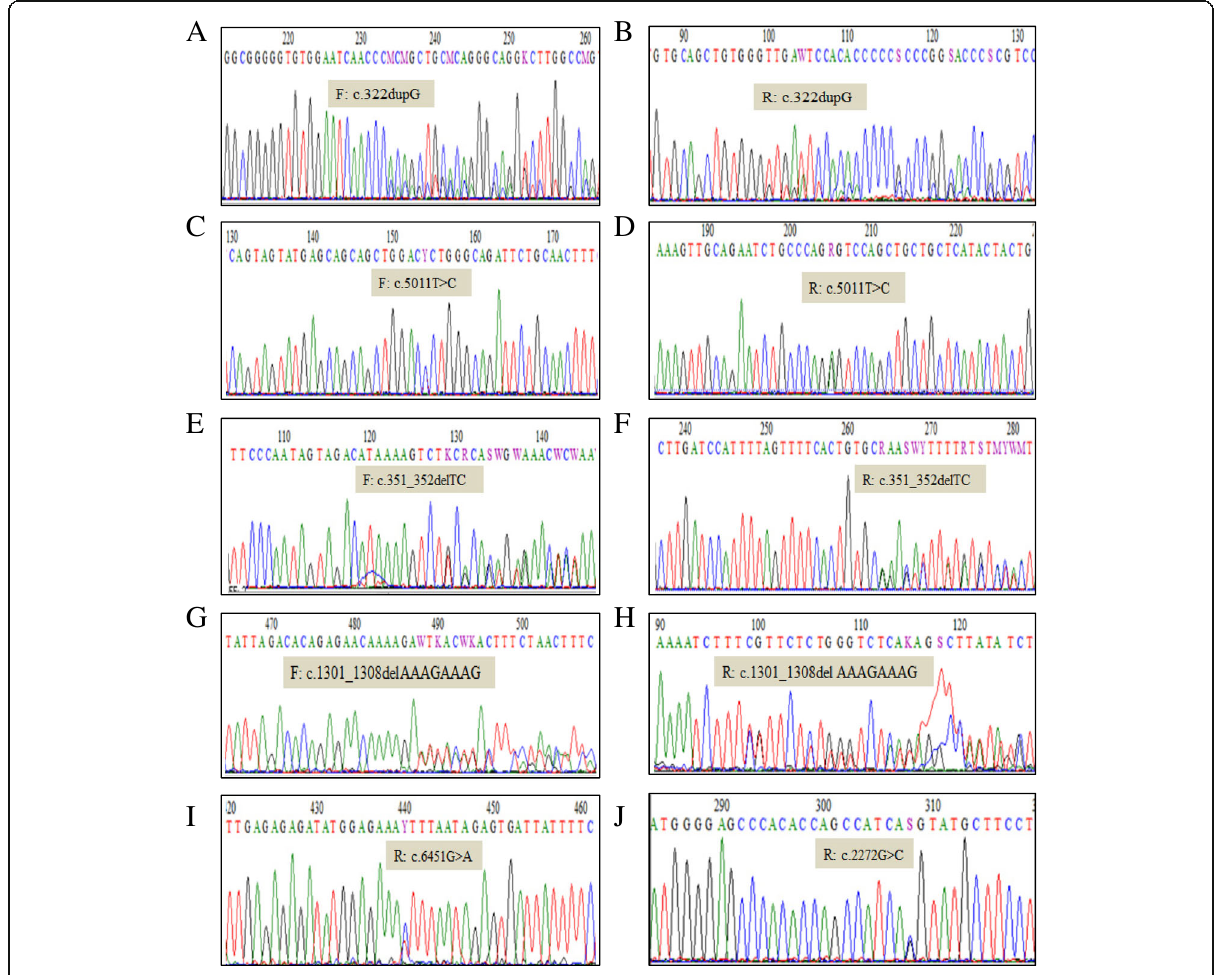
Fig. 1 Sequence chromatograms of all novel mutations detected in BRCA1, BRCA2, TP53, and ERBB2 genes. a and b Forward and reverse strands sequence of pathogenic frameshift insertion mutation c.322dupG in TP53 gene. c and ( d ) Forward and reverse strands sequence of pathogenic missense mutation c.5011T>C in BRCA1 gene. e and f Forward and reverse strands sequence of pathogenic frameshift deletion mutations c.351_352delTC in BRCA2 gene. g and h Forward and reverse strands sequence of pathogenic frameshift deletion mutationc.1301_1308del AAAGAAAG in BRCA2 gene. i and j Reverse strand sequence of missense mutation c.6451G>A and c.2272G>Cin BRCA2 and ERBB2 genes